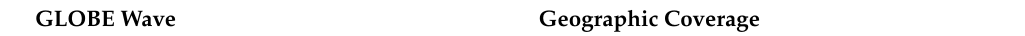
Geographies of the Global Leadership and Organizational Behavioral E ff ectiveness (GLOBE)